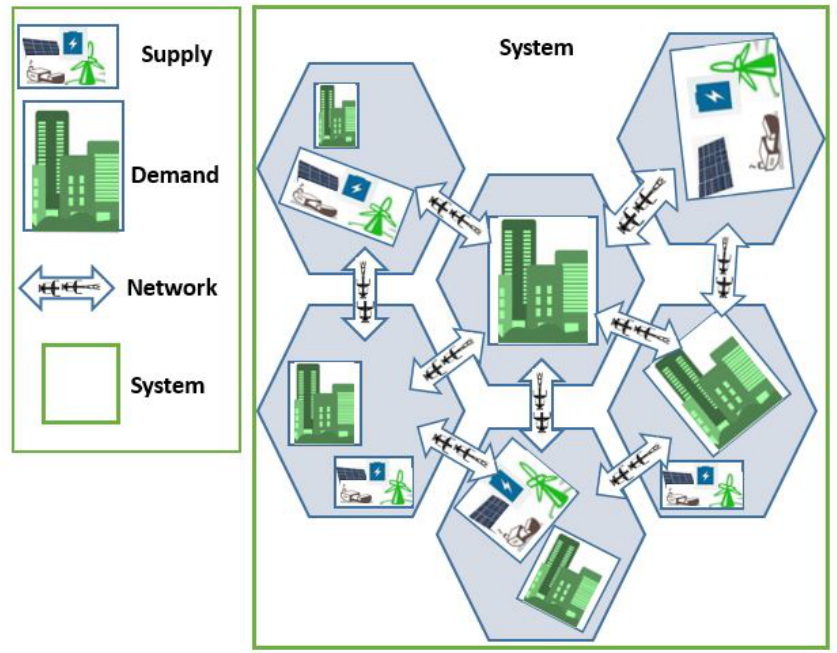
Figure 1. Interaction between the key components of